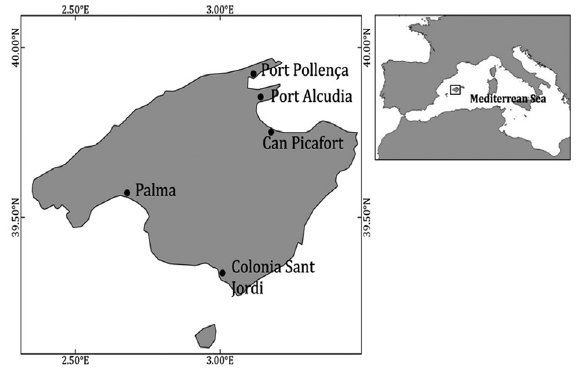
Fig. 1. – Sampled ports of the transparent goby fishery of Mallorca Island (western Mediterranean).